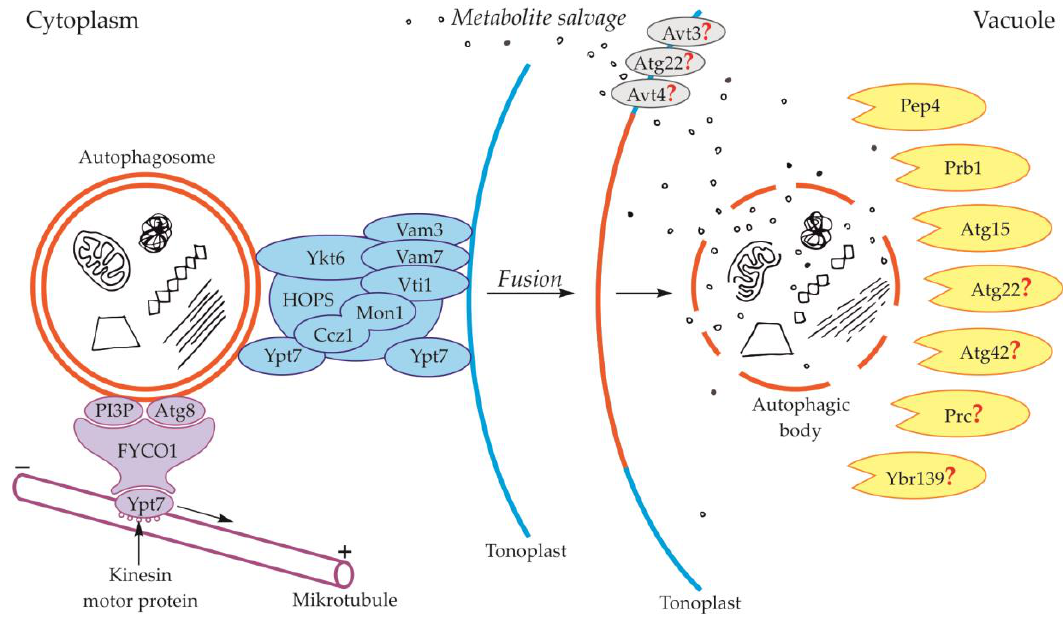
Figure 2. Schematic diagram depicting trafficking and fusion of the autophagosome to the vacuole and degradation of the autophagic body inside the vacuole in yeast. PI3P and Atg8 anchored in the outer membrane of the autophagosome are involved in autophagosome trafficking and bind the autophagosome with FYVE and coiled-coil domain-containing protein 1 (FYCO1). The complex autophagosome-FYCO1-Ypt7 moves along microtubules in the direction of the plus end by the binding of Ypt7 to kinesin motor proteins. Proteins Vam3, Vam7, Vti1, Ykt6, Ypt7, and complexes Ccz1-Mon1 and HOPS are involved in the fusion of the autophagosome and vacuole. The newly formed autophagic body inside the vacuole is rapidly degraded by lytic enzymes. Proteins involved in the degradation of the autophagic body are proteinase A (Pep4), proteinase B (Prb1), and putative lipase Atg15. Other proteins that are probably involved in the degradation of the autophagic body are Atg22, Atg42, Prc, and Ybr139. It is suggested that Atg22, Avt3, and Avt4 are involved in metabolite e ffl ux from the vacuole to the cytoplasm. Question marks indicate the hypothetical involvement of proteins in the degradation of the autophagic body and metabolite e ffl ux from the vacuole to the